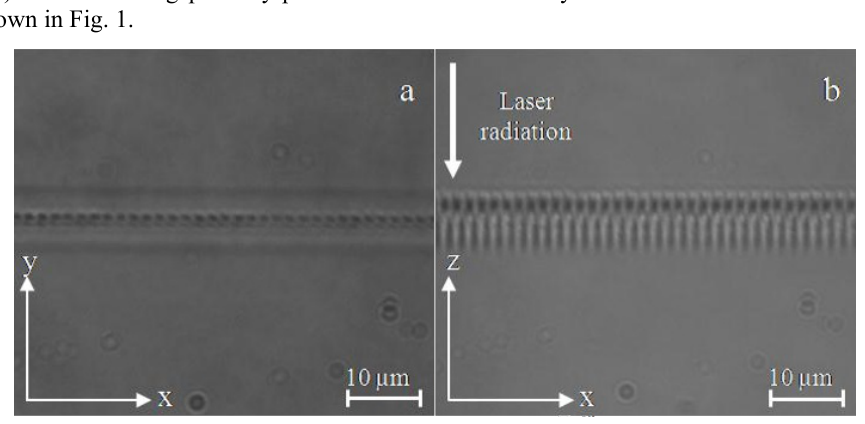
Fig. 1. Micrographs of fourth order FBG inscribed using point-by-point fabrication method: a – top view; b – orthogonal